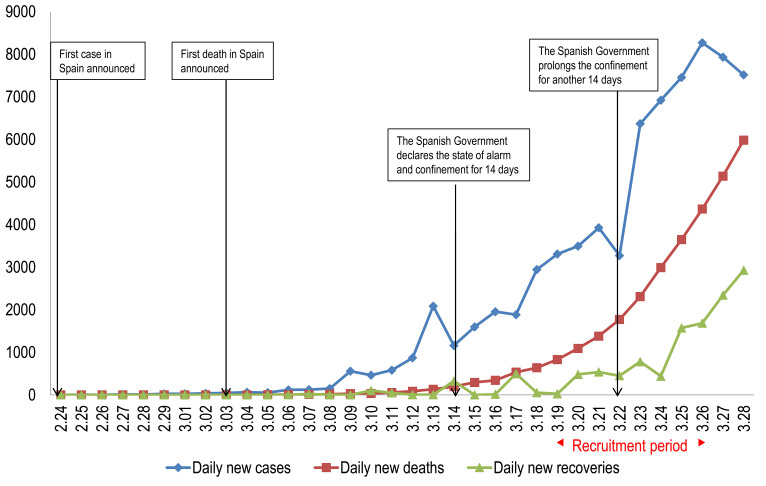
The national epidemic trend of the outbreak of the coronavirus disease 2019 (COVID-19) and socio-psychological milestones in Spain from February 24 to March 28, 2020.